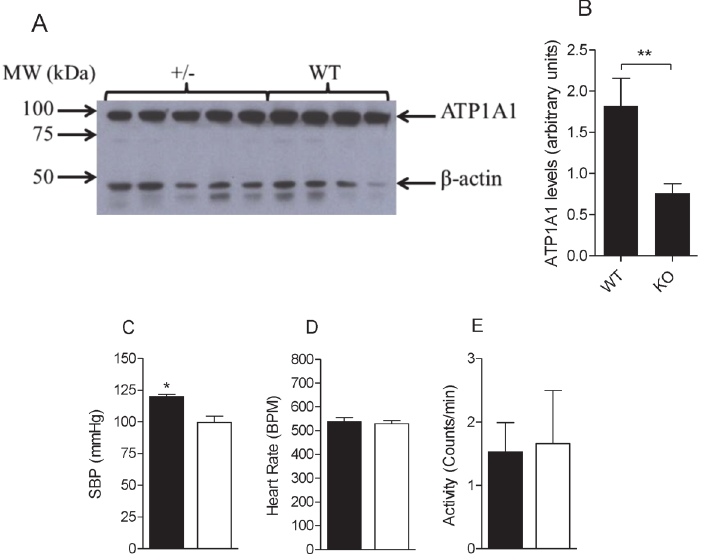
Figure 2. Analysis of ATP1A1 protein expression, blood pressure, heart rate and activity in heterozygous ATP1A1 +/ − and wild-type male mice. (A) Western blot analysis of ATP1A1 +/ − and wild type mouse whole kidney extracts (30 μ g) reacted with anti-mouse ATP1A1 and anti-mouse β Actin polypeptides. (B) Densitometry analysis of samples shown in (A) detecting 58% decrease ATP1A1 levels in ATP1A1 +/ − kidneys. (C) Mean systolic blood pressure (cid:3) sem (SBP; mmHg). (D) Mean heart rate (cid:3) sem (beats/min; BPM). (E) Mean activity (cid:3) sem (Counts/min) in ATP1A1 +/ − (solid bars, n = 4) and wild-type (open bars, n = 5) male mice. * P < 0.03, ** P = 0.015 (two-tailed student t -test).